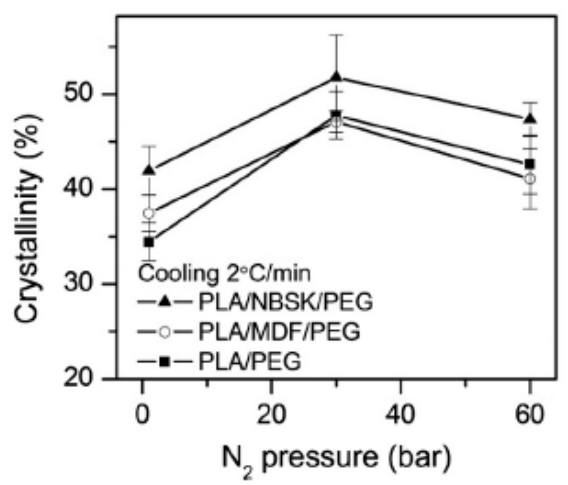
Figure 21. Degree of crystallinity of the PLA composites at a cooling rate of 2 °C/min under various N 2 pressures. Reprinted from Ding et al. [138]. Copyright (2020), with permission from Elsevier.